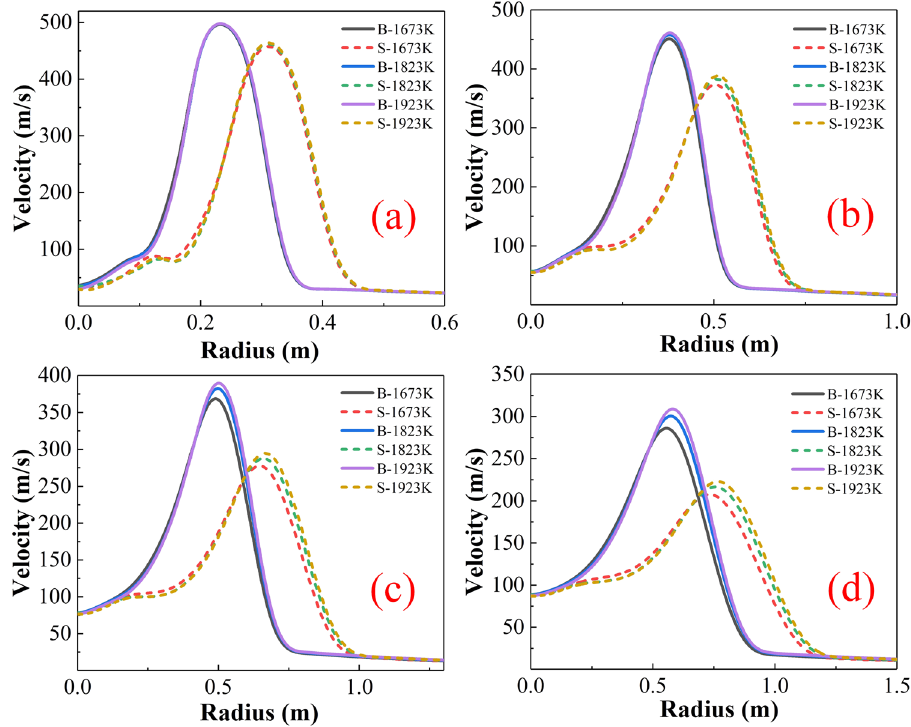
Figure 7: Radial velocity distribution of the jet at di ff erent temperatures: ( a ) 600 mm, ( b ) 1,300 mm, ( c ) 2,000 mm, and ( d ) 2,700